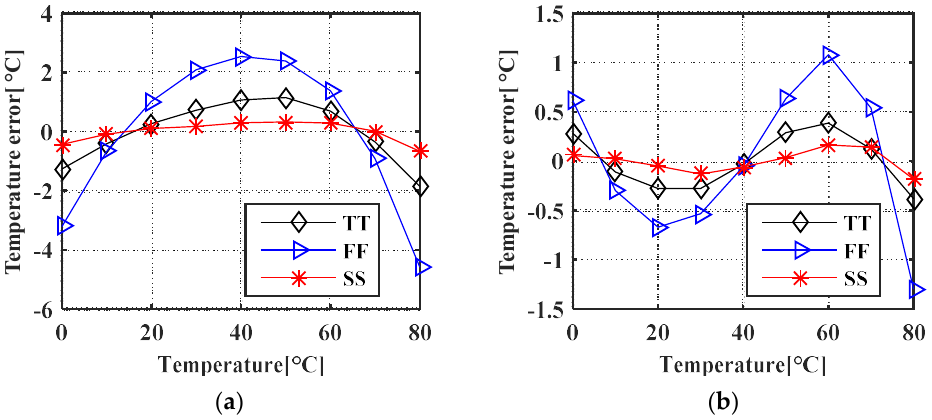
Figure 13. Simulated temperature error vs corners ( a ) after 1st order polyfit; ( b ) after 2nd order polyfit.